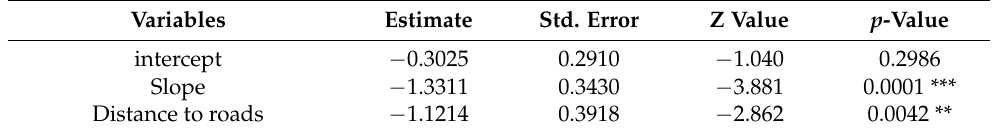
Table 8. Results of the logistic regression model predicting tropical dry forest gain using slope and distance to roads as predictive variables. ‘**’ Significant at 0.01 level, ‘***’ significant at 0.001 level.